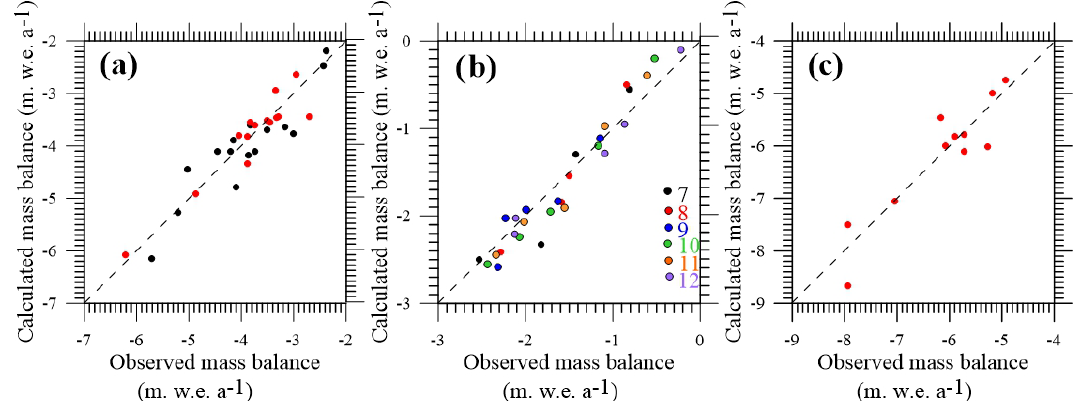
Figure 12. Observed and calculated point surface mass balances from (a) two ablation stakes located at 2550ma.s.l. at Argentière Glacier measured between 2002 and 2018, (b) six stakes located at around 2700ma.s.l. at Argentière Glacier measured between 2006 and 2017 and (c) one stake located at 2100ma.s.l. on Mer de Glace glacier measured between 2003 and